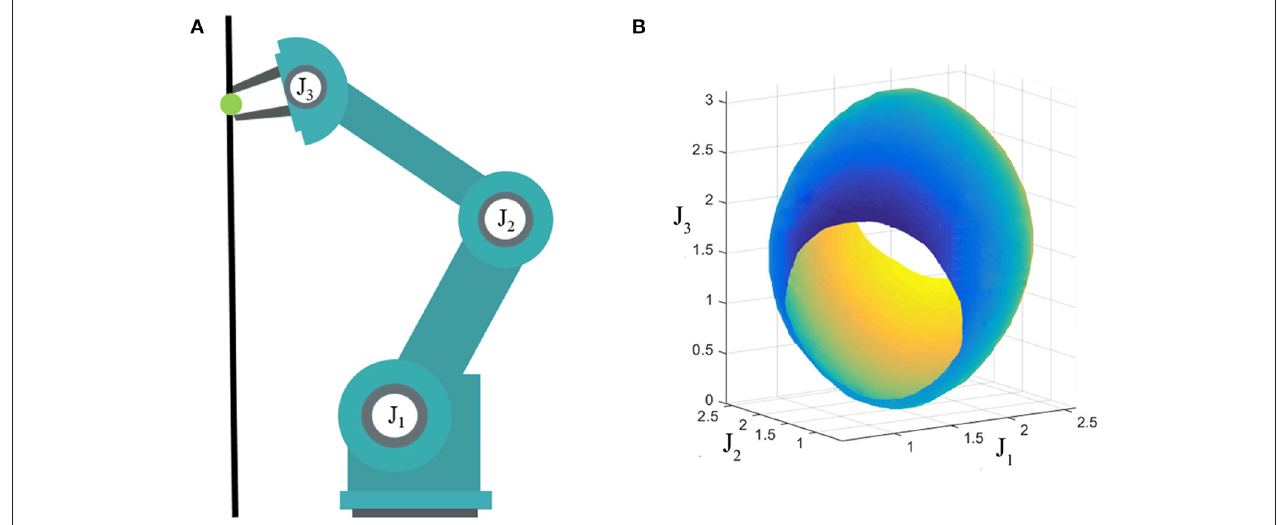
FIGURE 2 | (A) Three degree-of-freedom (DOF) robot; (B) Constraint manifold. The end effector of a three-DOF robot is constrained on the black line, which means that the robot has only two-DOF in the workspace. The configurations satisfying the constraint form a two-dimensional manifold in the C-space which is shown in (B)